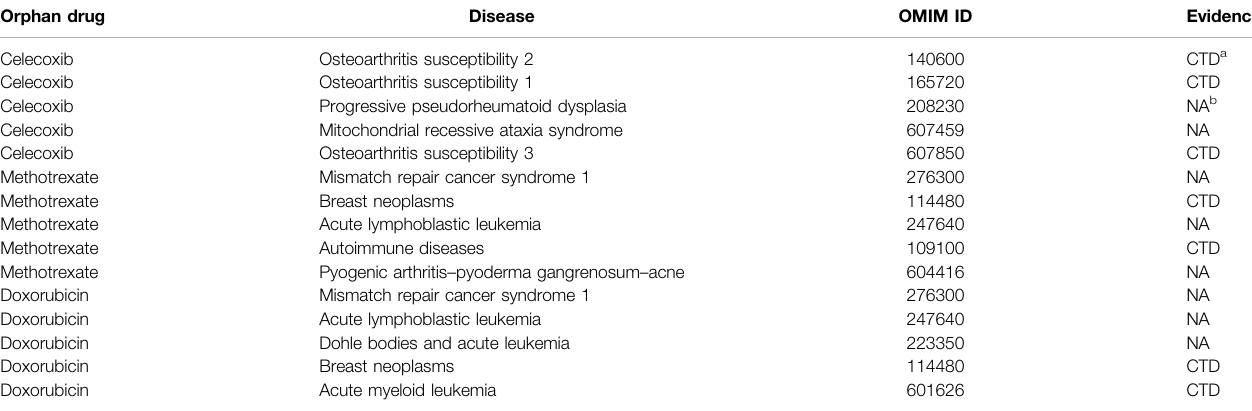
TABLE 4 | Top fi ve candidate diseases for typical orphan drugs. Orphan drug